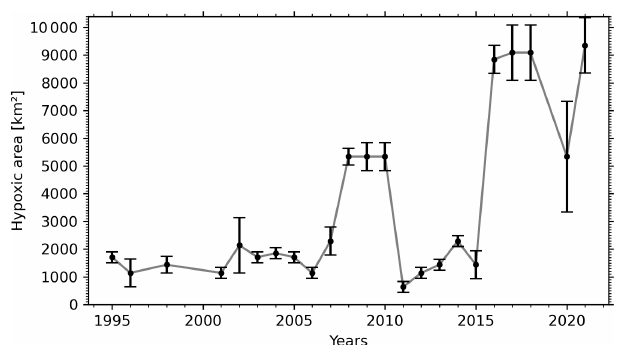
Figure 6. Temporal variation of the areal extent of the hypoxic zone in the Laurentian Channel. The error bars indicate the uncertainty associated with each year’s estimate, based on the spatial sampling rate (see Sect.